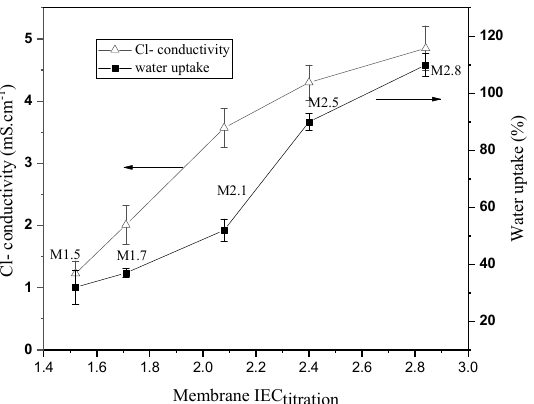
Figure 3. Water uptake and conductivity of the AEMs as function of titration IEC at 25 °C. The commercial reference membrane FAA − 3-50 ® (thickness: 50 ± 5 µ m; IEC